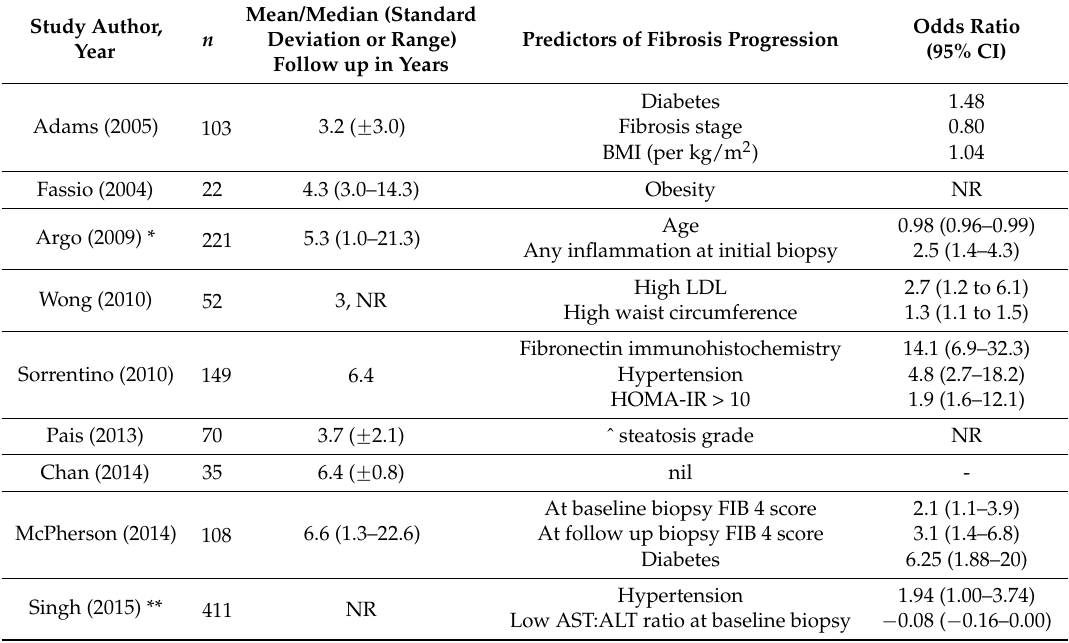
Table 1. Risk factors for fibrosis progression in non-alcoholic fatty liver disease (NAFLD): Results from paired liver biopsy